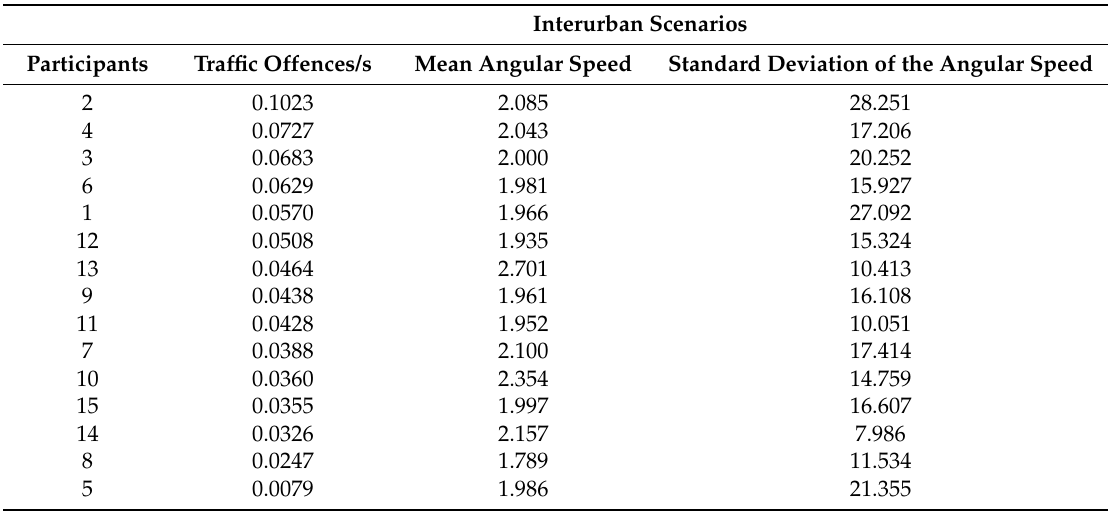
Table 2. Participants ordered as a function of the number of traffic offences per second in interurban scenarios.